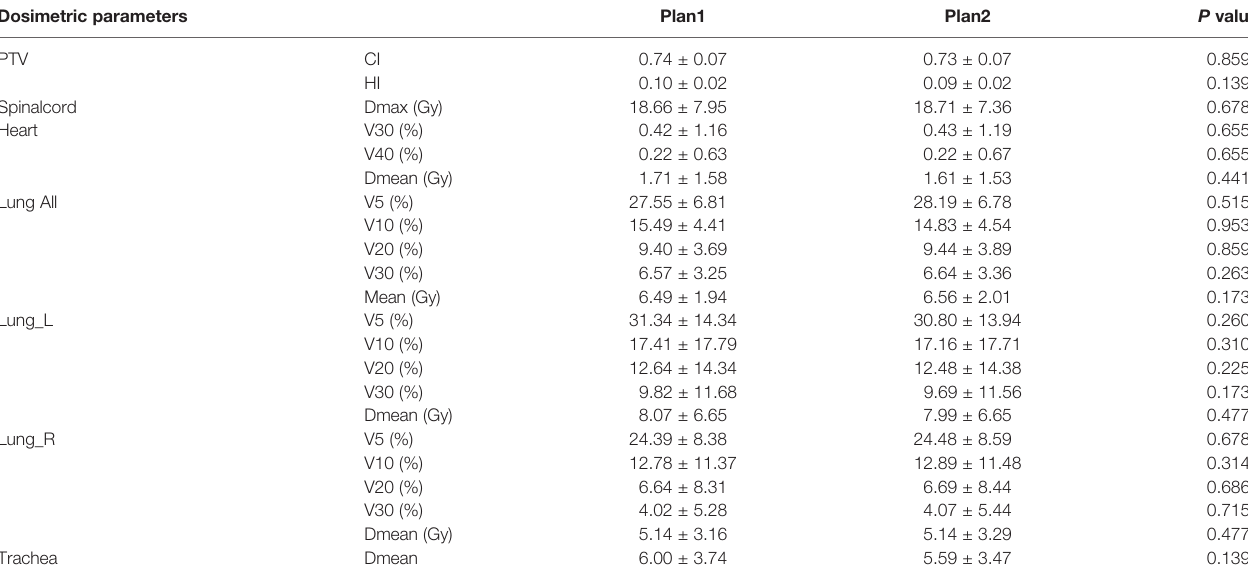
TABLE 5 | Dosimetric comparison of the PTV and OARs between manual and automatic segmentation-based plans ( (cid:2) x ± s ). Dosimetric